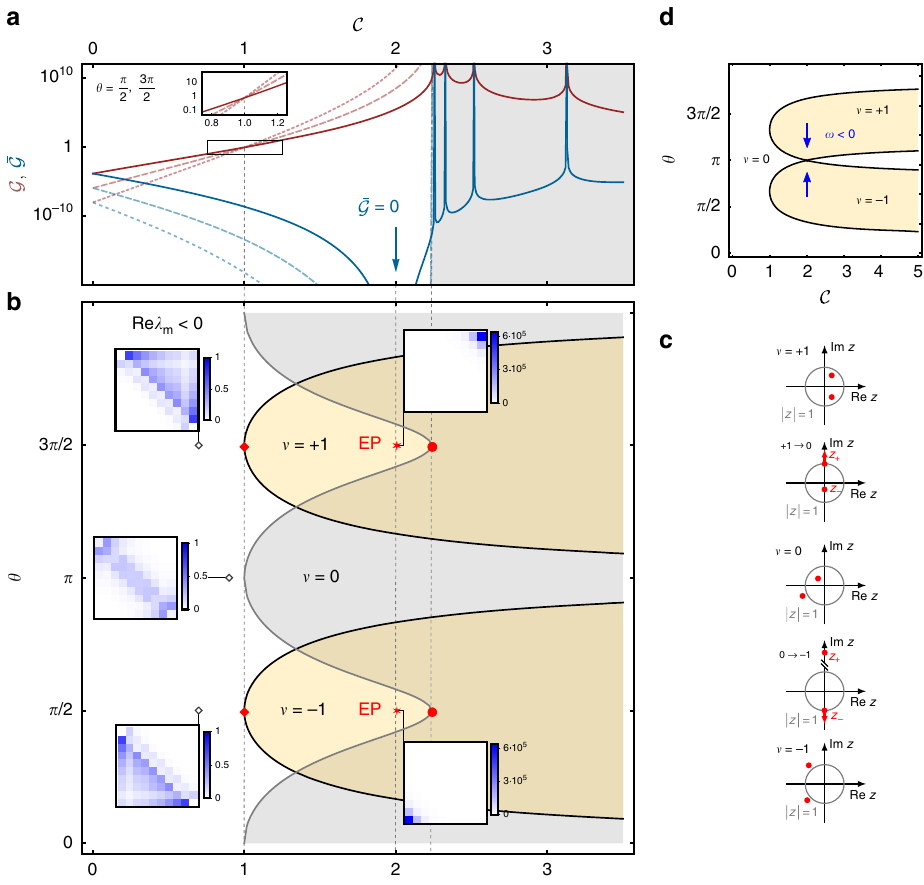
Fig. 3 Topological ‘ phase diagram ’ of the scattering matrix. a Gain Gð 0 Þ and reverse gain (cid:2) Gð 0 Þ , see Eqs. (5) and (6), respectively, for N = 10 (solid line), N = 15 (dashed), N = 20 (dotted), all for θ ¼ π ; 3 π , and b general topological ‘ phase diagram ’ on resonance, ω = 0, with distinct winding numbers according 2 2 to Eq. (11). We can associate a scattering matrix S (0) with each point in the diagram and we show some ∣ S (0) ∣ 2 as inset with Λ = 2 and γ = 2 Γ − κ in Eq. (9) to obtain impedance matching at the exceptional point (EP). Note in particular the color scales of the scattering matrices revealing the ampli fi cation, and the asymmetry of the matrix signifying non-reciprocity. Condition (15) yields the orange lobes in b and corresponds to winding numbers ν = ±1, whereas the rest is the trivial regime ν = 0. Directional ampli fi cation, i.e., G > 1, sets in as we move into a topologically non-trivial regime. For the parameters shown in a this occurs at C ¼ 1. In this regime, the gain grows exponentially with N . At the EP the transmission in the reverse direction is completely suppressed, i.e., (cid:2) G ¼ 0, and the upper (lower) triangle of S (0) is exactly zero. The system becomes unstable (gray overlay), when max m Re λ m > 0, in which λ m is the m th eigenvalue of the dynamic matrix M obc (0), see Eqs. (3) and (47). Re λ m ¼ 0 coincides with the onset of the parametric instability and can be seen as divergence in the gain in a . Non-reciprocity also occurs outside of non-trivial topological regimes and is governed by the phase θ . Complete directionality is achieved at θ ¼ π for ν = − 1 from left to right ( 3 π for ν = + 1 from right to left). While the gain only depends 2 2 weakly on Λ , larger (smaller) Λ shifts the location of the EP to the right (left) and extends (shrinks) the stable regime. c The number of zeros inside the unit circle determines the winding number. On the boundary between trivial and non-trivial regimes, one of the zeros lies on the unit circle and hence G ¼ Oð 1 Þ independent of N , see ( a ) at C ¼ 1. d Off-resonance, ω ≠ 0 shifts the two lobes corresponding to non-trivial topological regimes ν = ±1 towards each other. Where they overlap, we obtain a trivial